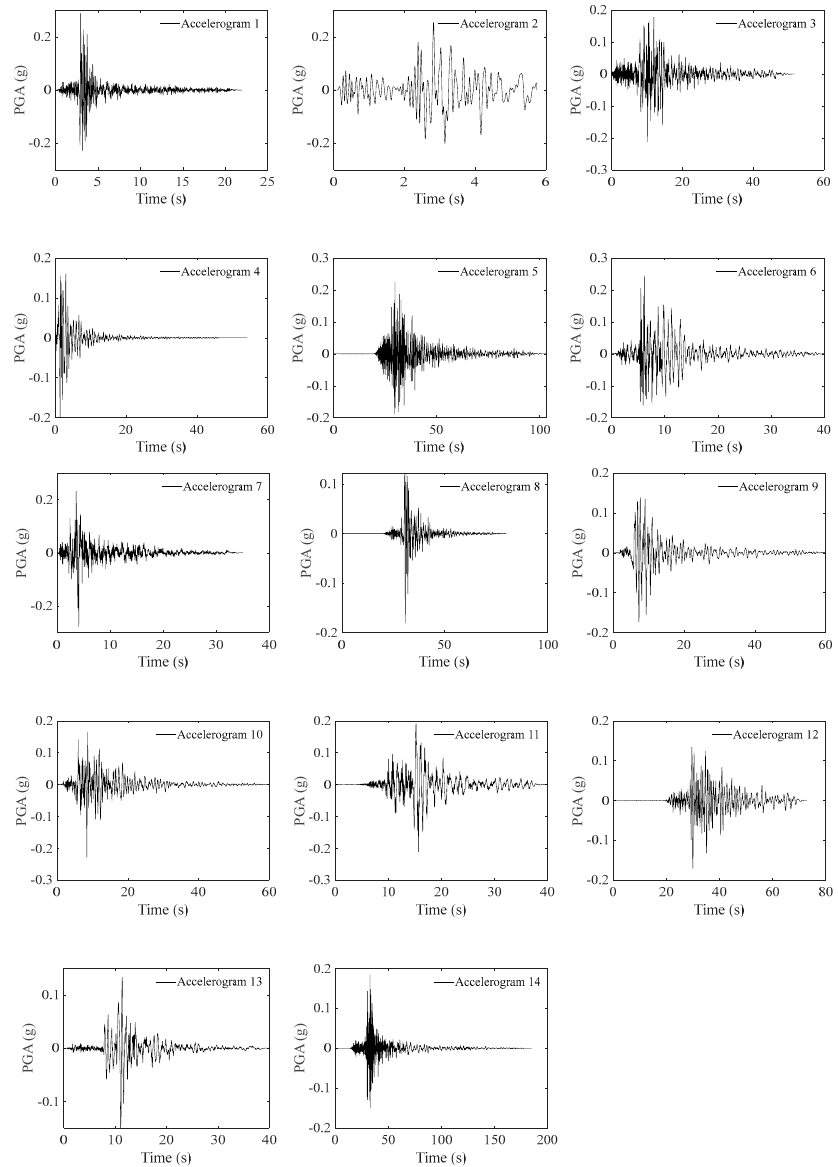
Figure A4. Soil − surface accelerograms generated from QuakeAdvice.